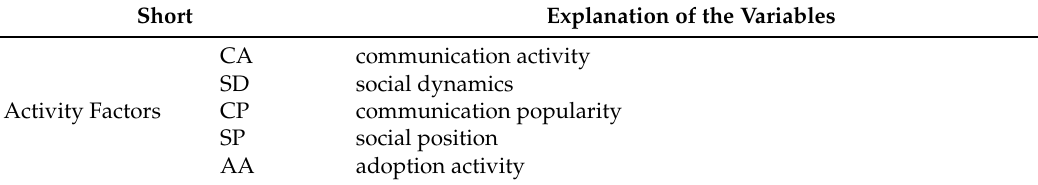
Table 1. Abbreviations of variables with their short description used in the article. Explanation of the